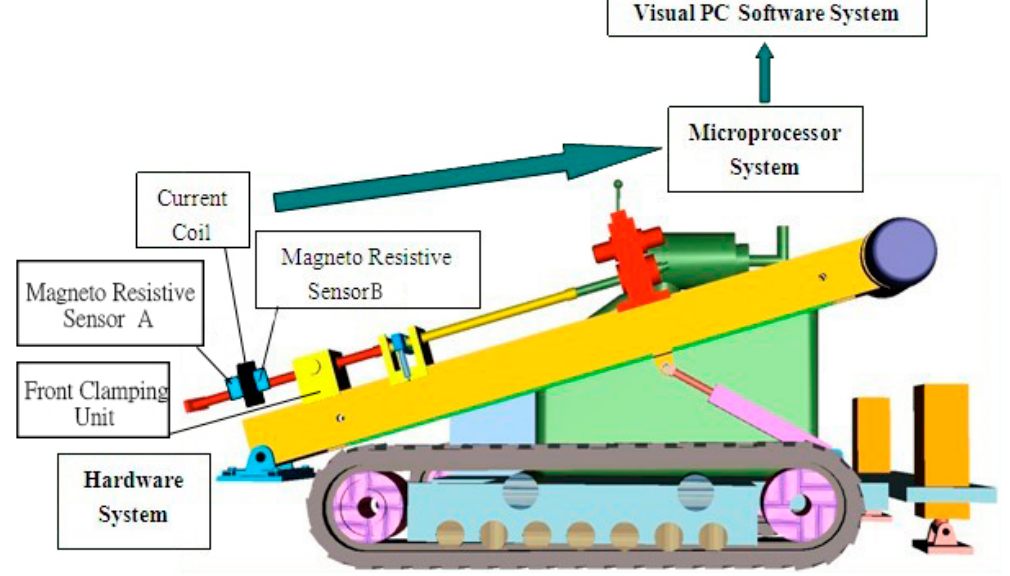
Figure 4. Installation diagram of contactless detection system.